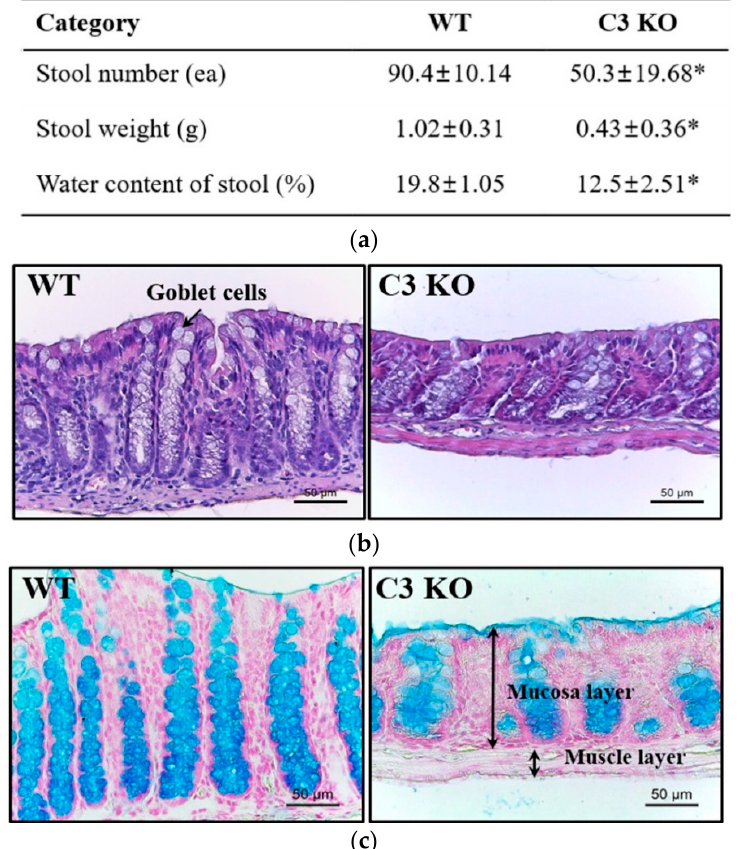
Figure 1. Determination of the constipation phenotypes in C3 KO mice. ( a ) Stool parameters. After collecting the stools from a metabolic cage, their number, weight, and water contents were measured, as described in Section 4. Seven mice per group were used for stool collection, and each parameter was assayed in duplicate. The data are reported as the mean ± SD values. * p < 0.05 compared with the WT group. ( b ) Histological structure of the mid colon. H&E-stained sections of the mid colon from WT and KO mice were observed at 100× and 400× magnification using a light microscope. Five mice per group were used to prepare the H&E-stained slides, and the histopathological structures were observed in duplicate in each slide. ( c ) Mucin staining of the mid colon. Alcian blue-stained sections of the mid colon from WT and KO mice were observed at 100× and 400× magnification using an optical microscope. Three mice per group were used to prepare Alcian blue-stained slides, and density changes were observed in duplicate in each slide. Abbreviations: WT, wildtype; KO, knockout; H&E, hematoxylin and